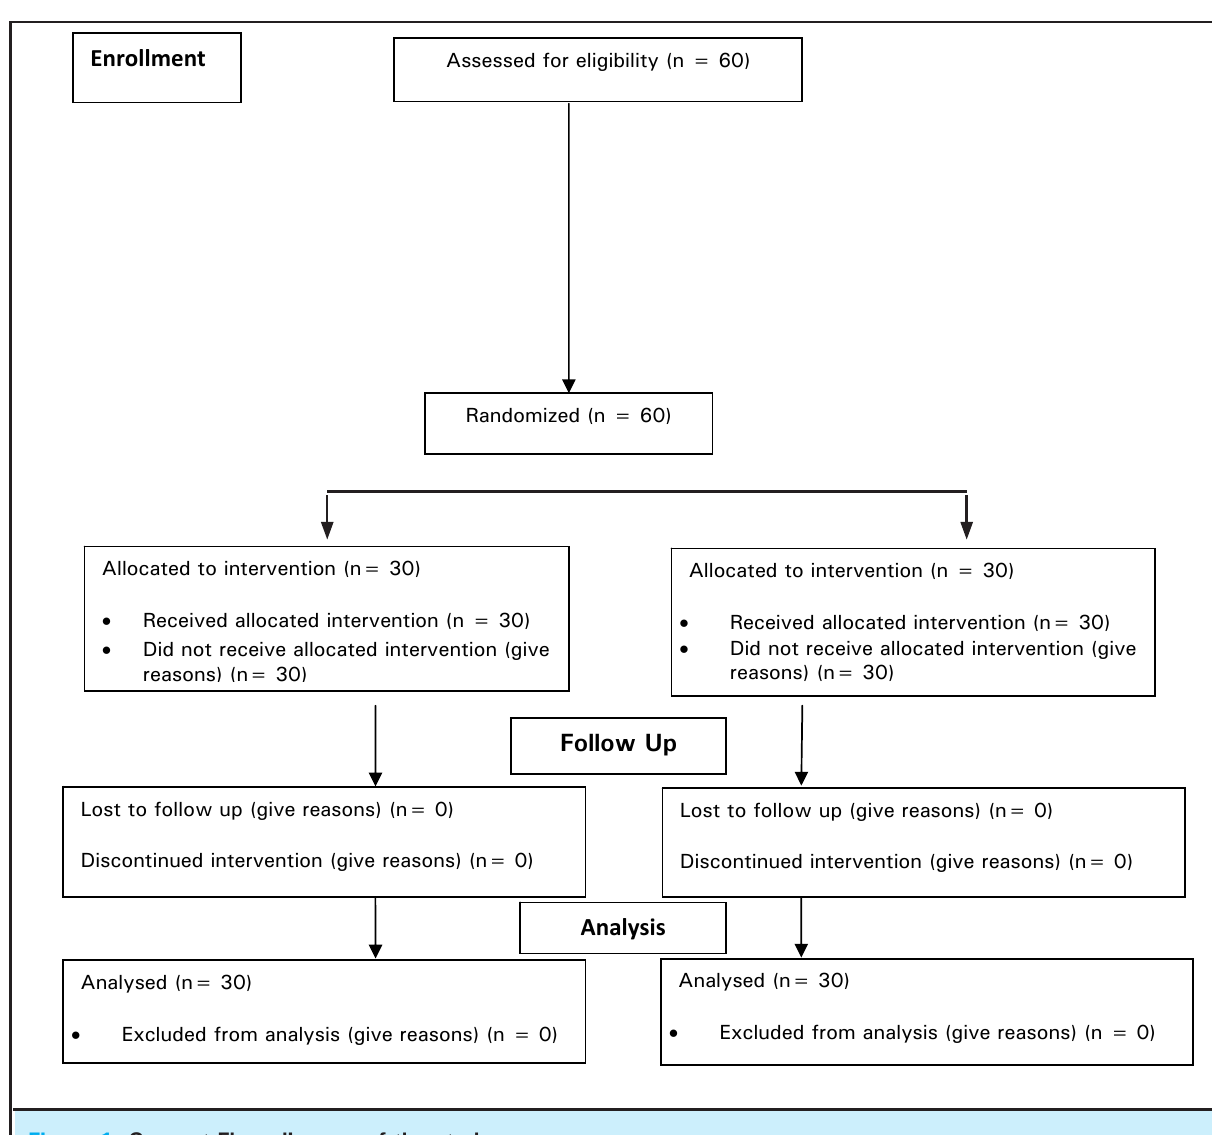
Figure 1. Consort Flow diagram of the